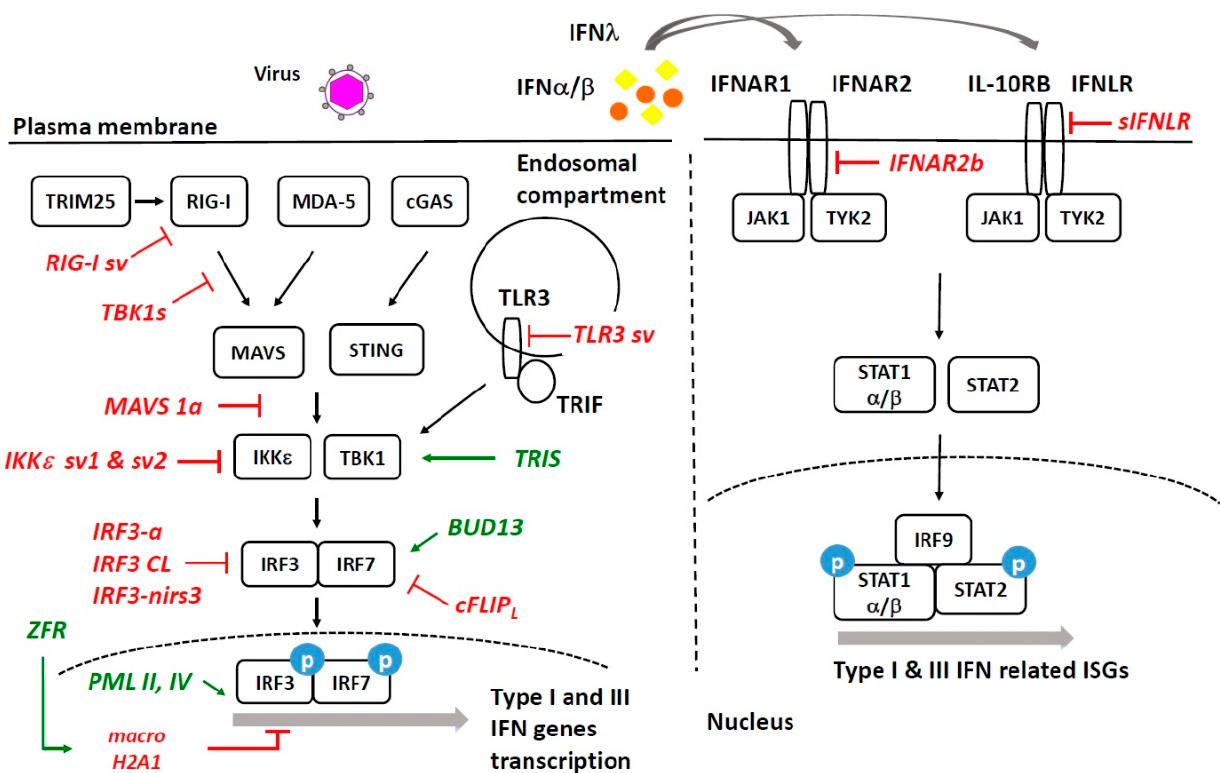
Figure 1. Alternative splicing in the host Type I and Type III IFN response. AS isoforms that upregulate the antiviral response are shown in green, and those that downregulate the antiviral response are shown in red.